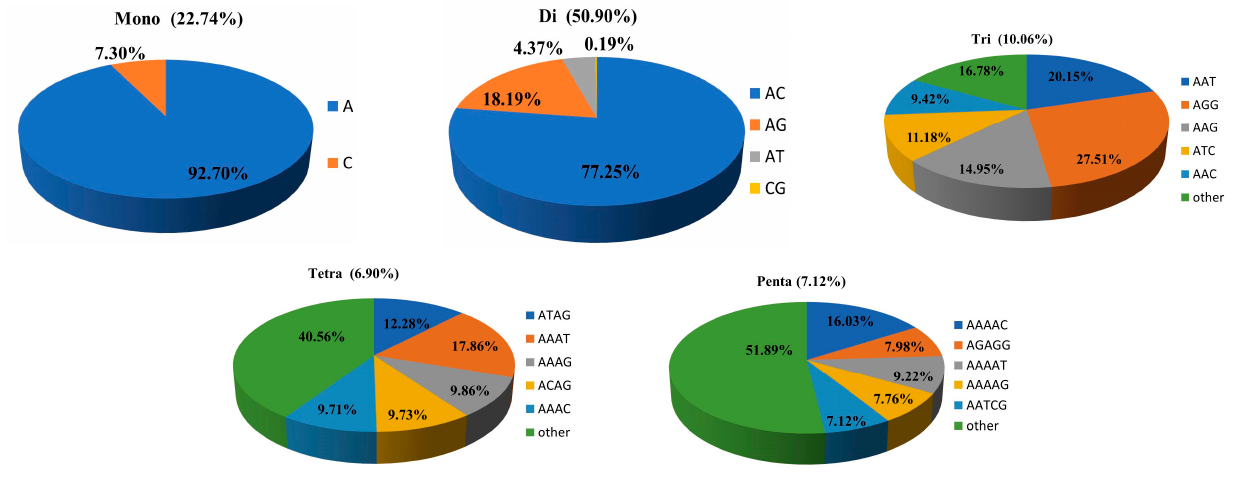
Figure 2. Frequency distribution of different repeat motifs in the reference genome of blackhead seabream.